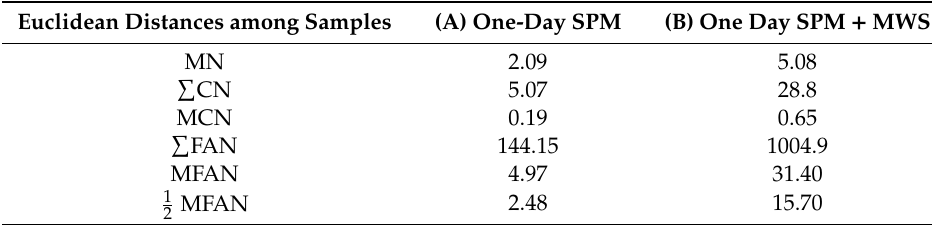
(cid:80) FAN), the mean